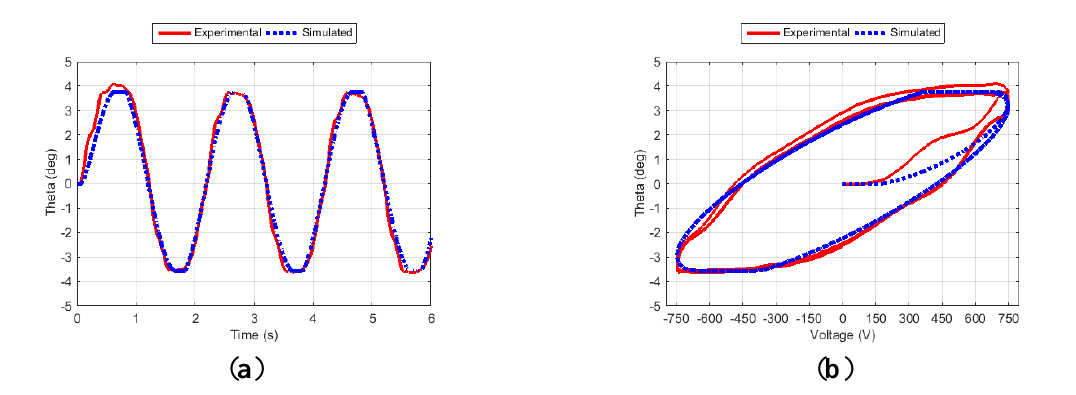
Figure 13. Fin angle ( a ) and hysteresis curve ( b ) for Case 8.